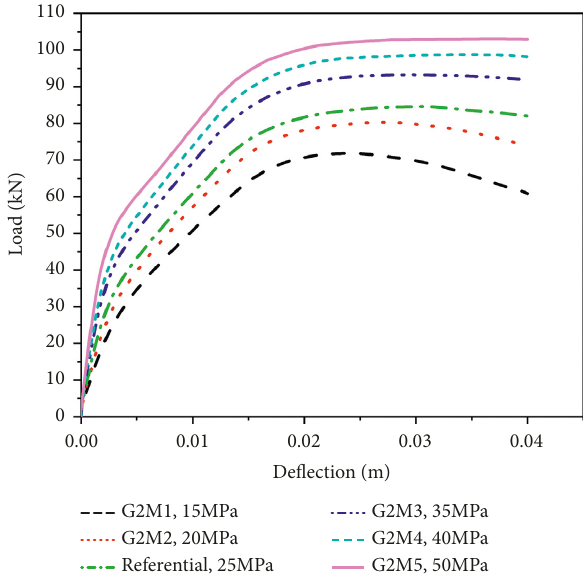
Figure 17: Load-deflection response for specimens with various concrete compressive strengths.